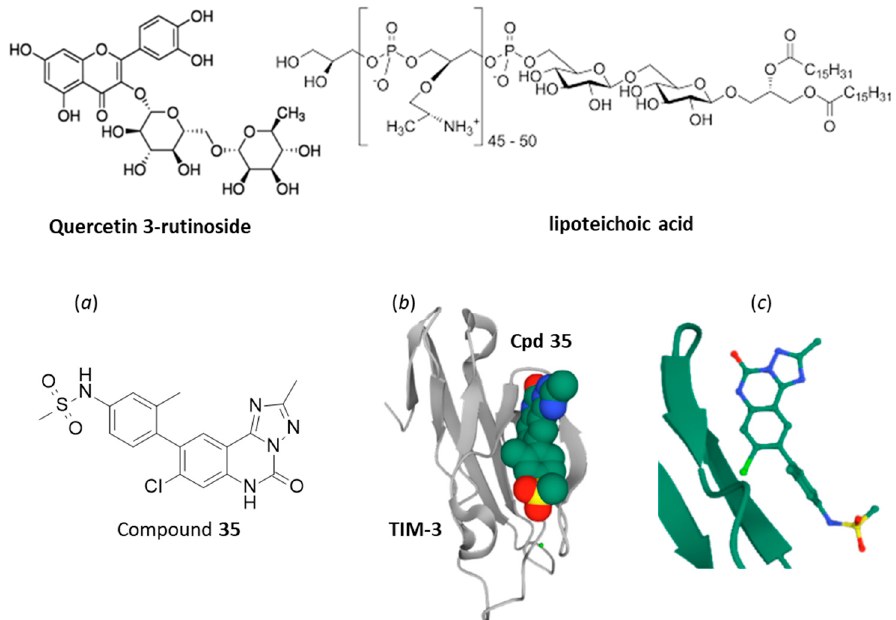
Figure 4. Small molecules known to bind to TIM-3 (or to regulate expression). ( top ) Rutin and lipoteichoic acid. ( bottom ) ( a ) Structure of the triazoloquinazolinone derivative 35. ( b ) Molecular model of cpd 35 bound to TIM-3. ( c ) A detailed view of Cpd 35 interfaced with the protein [95].